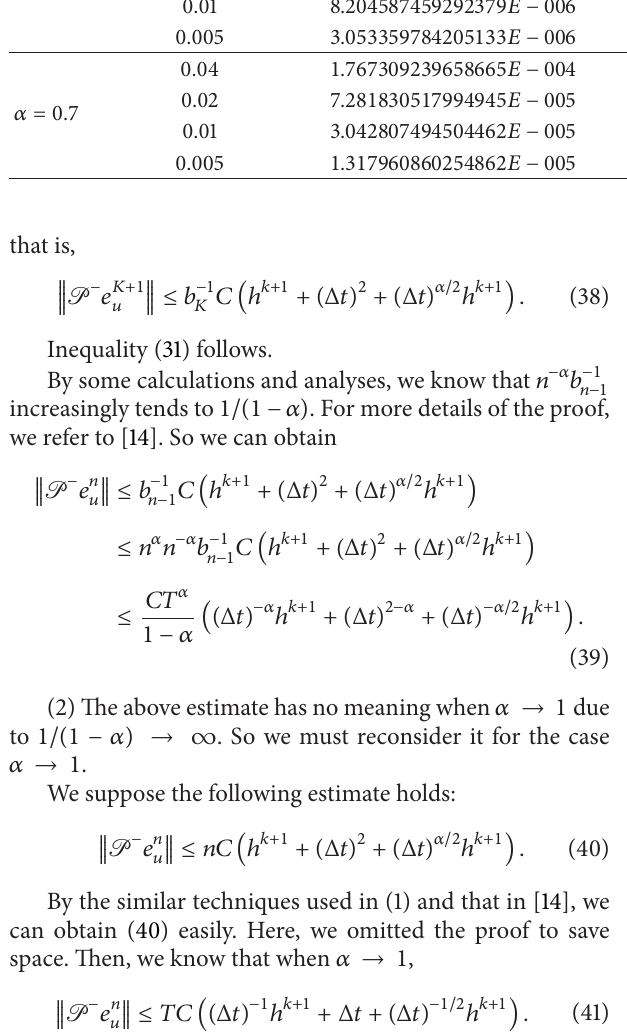
Table 10: Temporal accuracy test for the problem (1) with the forcing term (42) when 𝑁 = 100 , 𝑇 = 1 , and 𝑘 = 2 . Δ𝑡 𝐿 2 -Error Order 𝐿 1 -Error Order 0.04 — 5.728850142441670𝐸 − 005 — 1.48 1.48 𝛼 = 0.5 1.43 0.04 1.767309239658665𝐸 − 004 — 1.591263361456412𝐸 − 004 — 0.02 7.281830517994945𝐸 − 005 1.28 𝛼 = 0.7